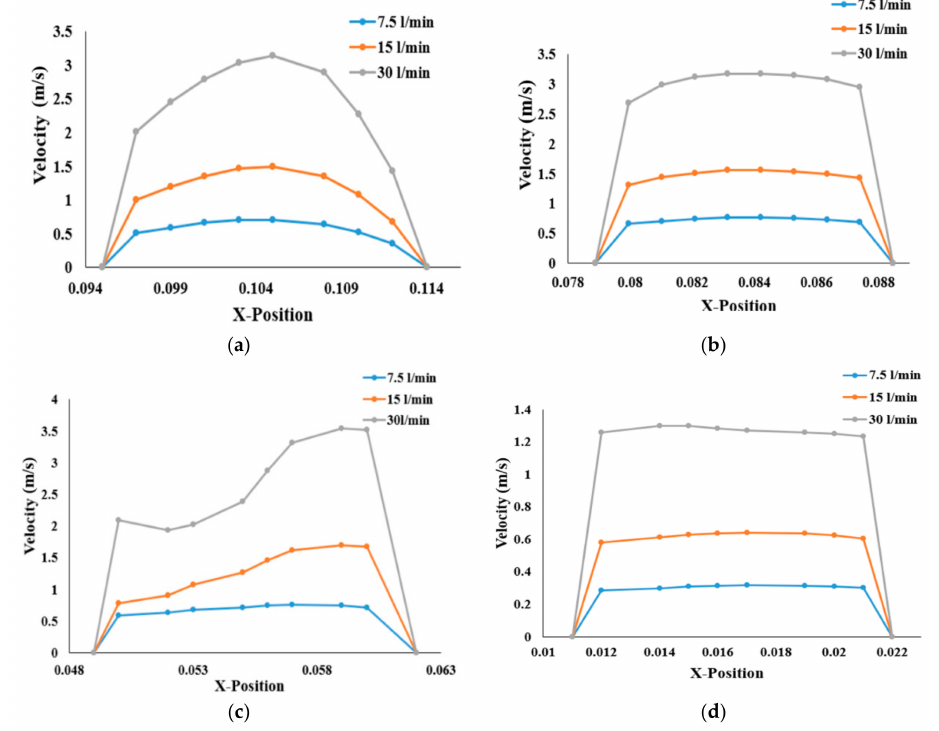
Figure 5. Velocity profiles for the healthy lung and three di ff erent flow rates, at ( a ) Line 1, ( b ) Line 2, ( c ) Line 3, and ( d ) at the third